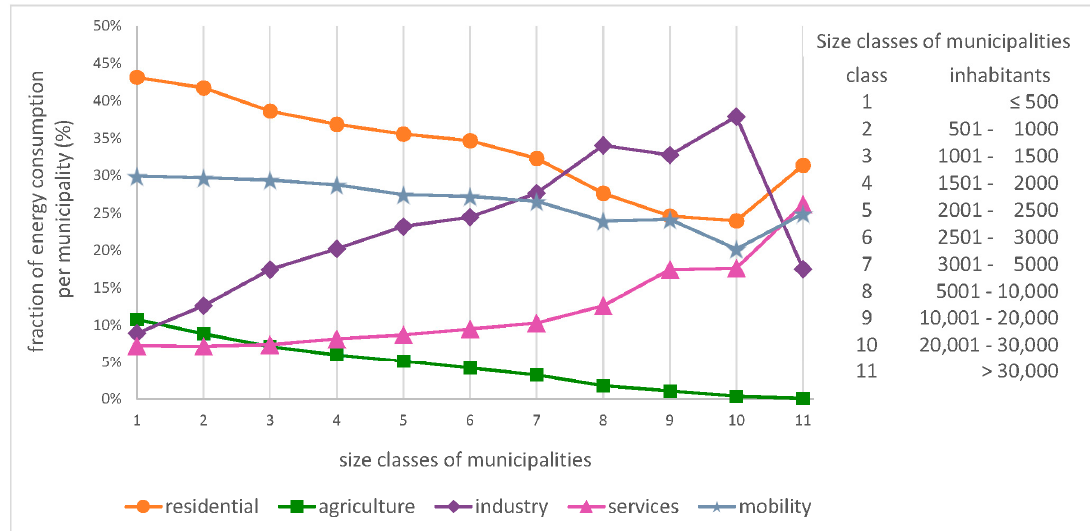
Figure 4. The significance of land use types according to the different municipality´s size ranges.